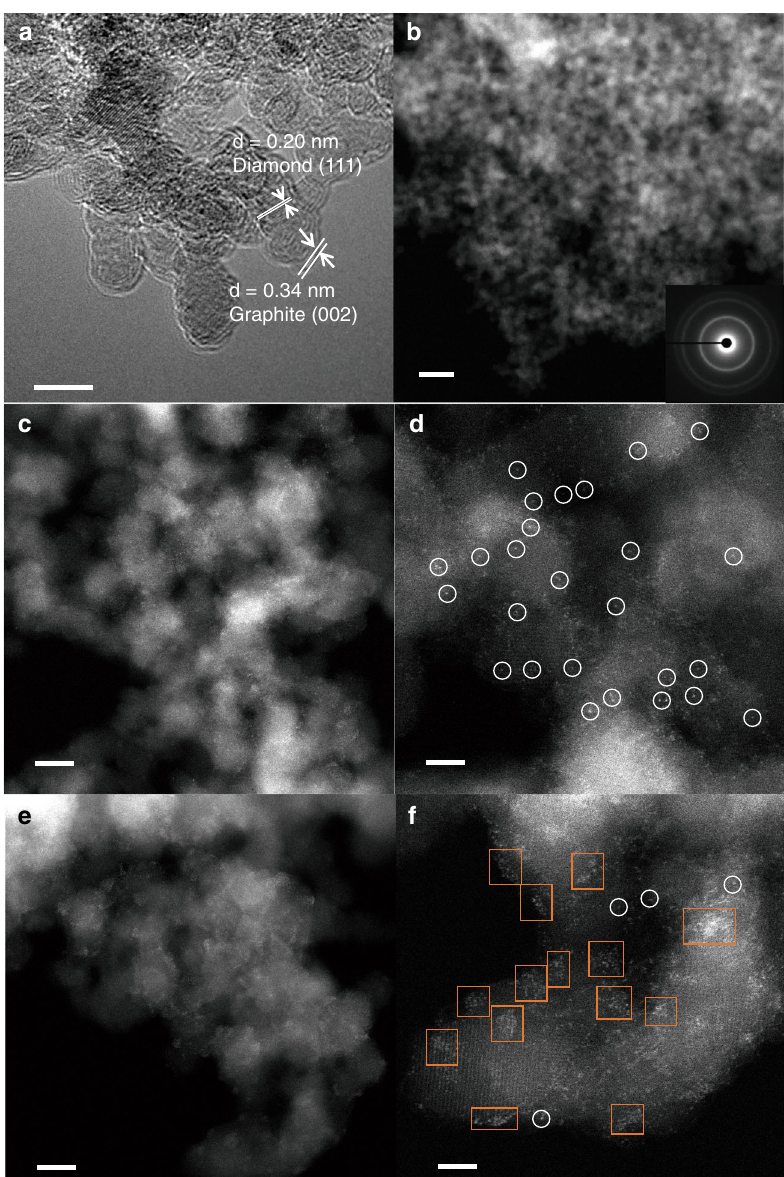
Fig. 1 TEM characterization of ND@G support and Cu 1 /ND@G and Cu n /ND@G catalysts. a HRTEM image of ND@G nanocarbon support. Scale bar, 5 nm. b HAADF-STEM image of Cu 1 /ND@G at low magni fi cation. Scale bar, 20 nm. c HAADF-STEM images of Cu 1 /ND@G at low magni fi cation. Scale bar, 5 nm. d HAADF-STEM images of Cu 1 /ND@G at high magni fi cation. Scale bar, 2 nm. e HAADF-STEM images of Cu n /ND@G at low magni fi cation. Scale bar, 5 nm. f HAADF-STEM images of Cu n /ND@G at high magni fi cation. Scale bar, 2 nm. (The inset attached to b is diamond ’ s diffraction rings ’ image. Atomically dispersed Cu atoms are highlighted by white circles in d and Cu clusters are highlighted by orange squares in f